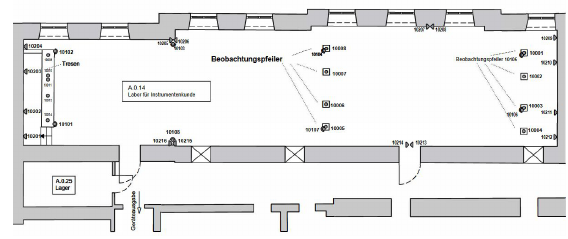
Figure 6. Floor plan of the test environment